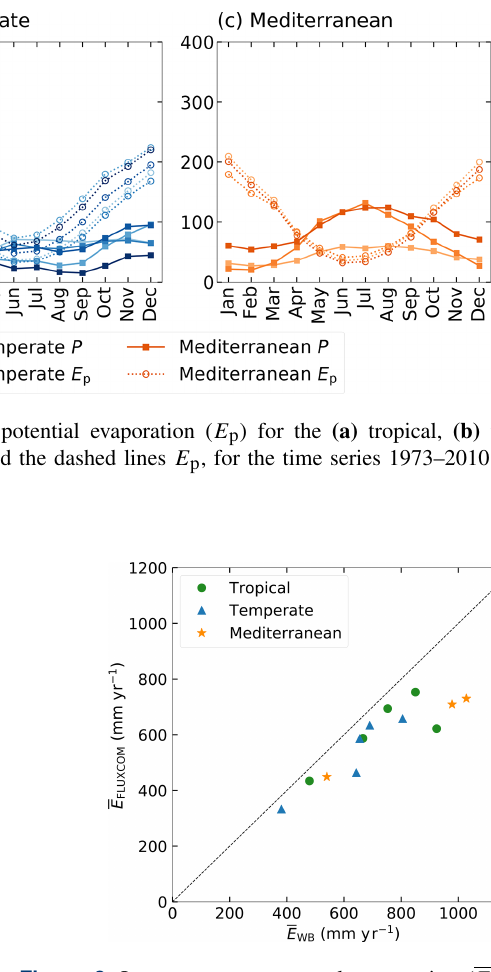
Figure 3. Long-term mean annual evaporation ( E ) as estimated from long-term water balance data ( E WB ) compared to the FLUX- COM dataset ( E FLUXCOM ) for the 1975–2010